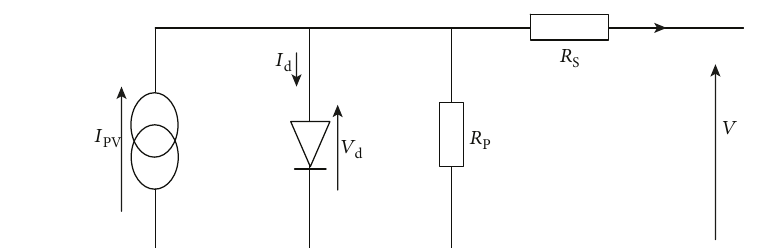
Figure 3: Equivalent circuit of a PV cell [22].